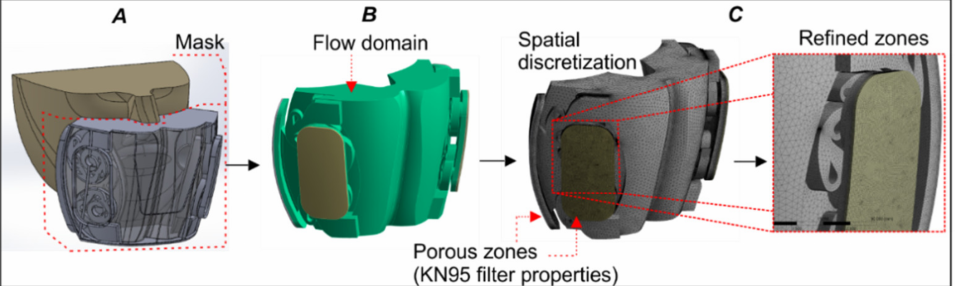
Figure 5. Control volume and spatial discretization of the air domain into the mask. ( A ) Mask geometry; ( B ) computational flow domain considering porous zones; and ( C ) spatial discretization of control